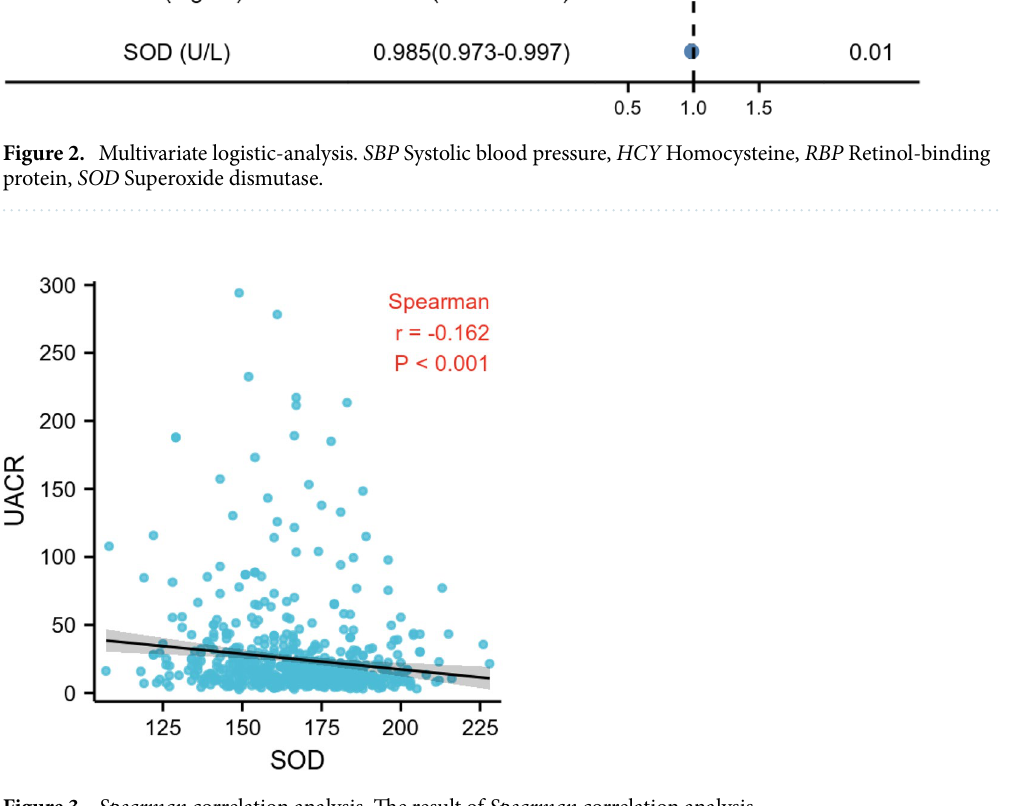
Figure 3. Spearman correlation analysis. The result of Spearman correlation